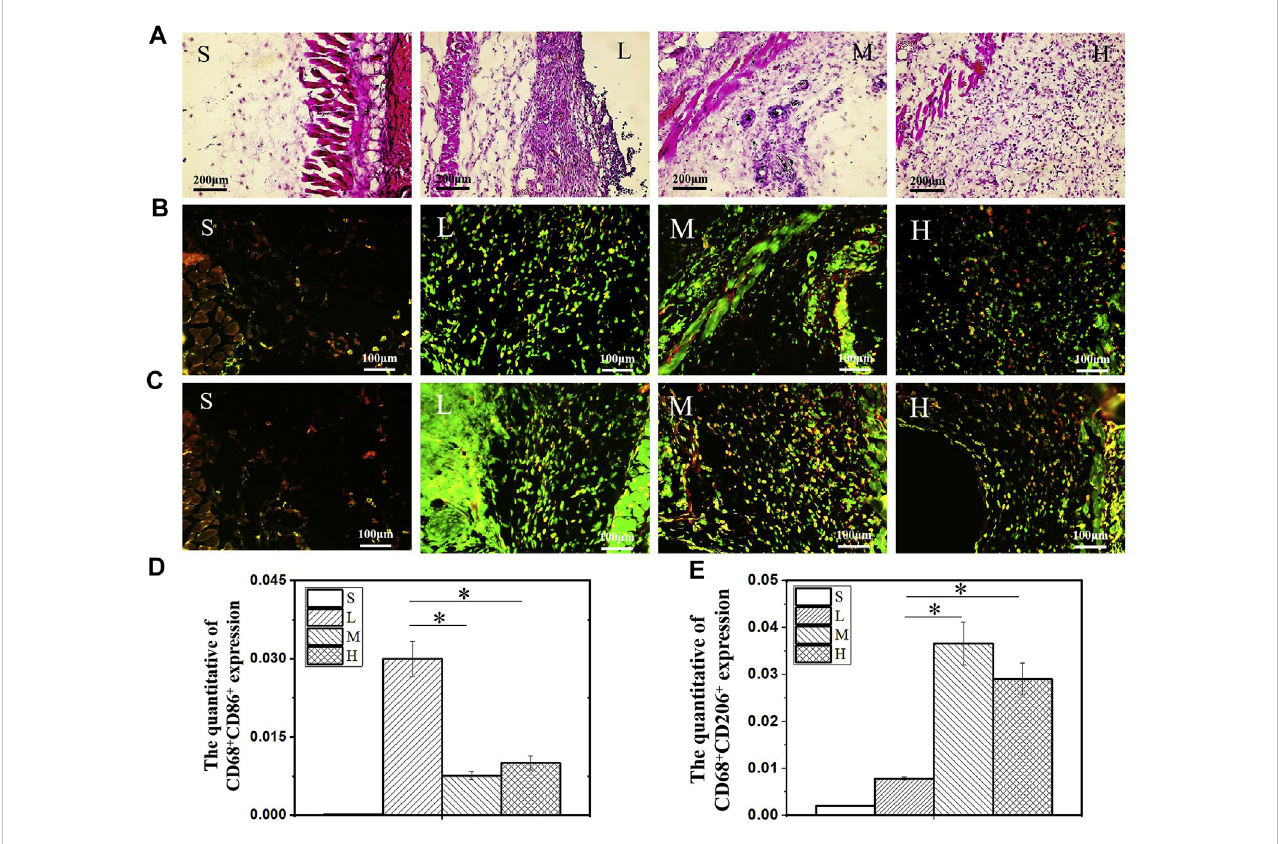
FIGURE 3 H & E staining image after 14 days of hydrogel subcutaneous implantation (A) . Immuno fl uorescence staining image of CD68 + CD86 + (B) and CD68 + CD206 + (C) macrophages after 14 days of hydrogel subcutaneous implantation. Quanti fi cation analysis of CD68 + CD86 + (D) and CD68 + CD206 +